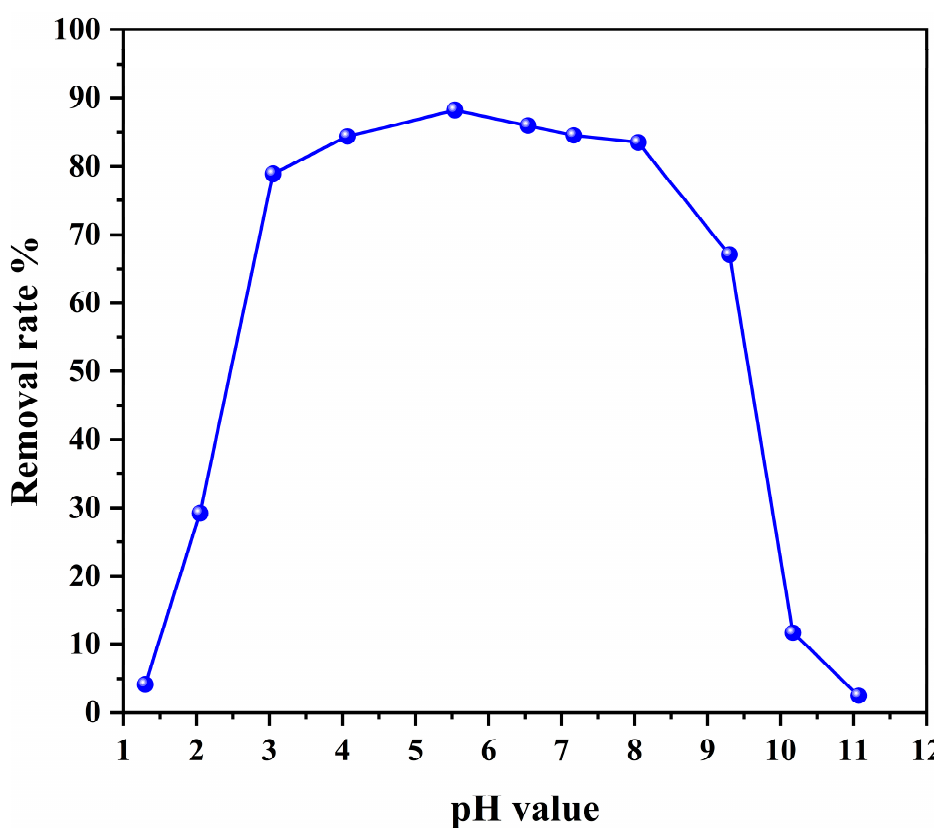
Figure 4. The pH effect on the removal efficiency for ReO 4 − by p-(Amide)-PAM. The dosage of the absorbent was 1 g/L, time was 240 min, initial concentration of ReO 4 − was 100 mg/L, and the temperature was 298.15 K.